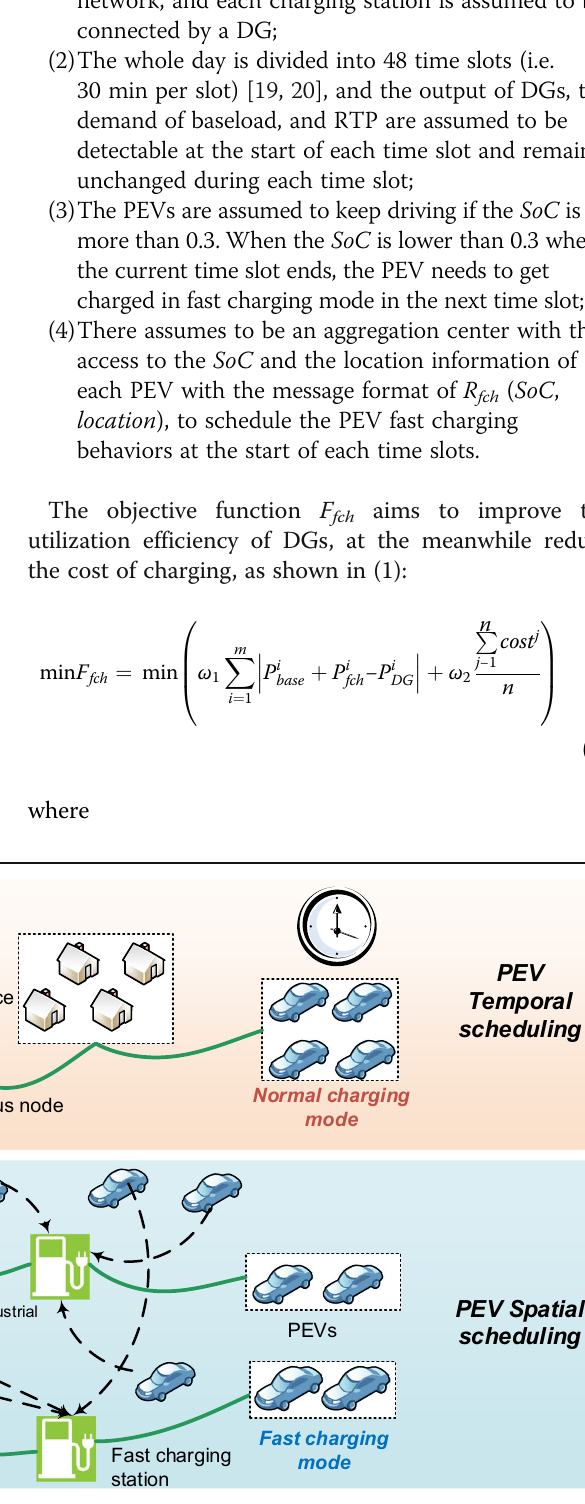
Fig. 1 The framework of the temporal-spatial scheduling